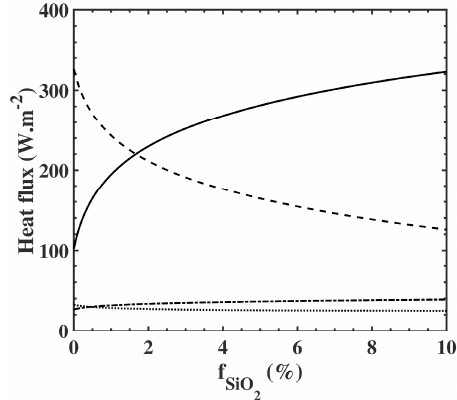
Figure 4. Representation of the radiated flux from the membrane ( m ), ( Q rad,m , black solid line), the transmitted flux from the ambient air ( a ) ( τ .Q rad,a , dashed lines), the reflected flux on the membrane toward the skin ( s ) ( ρ .Q rad,s , dotted lines), and the conducted flux through the microclimate ( mc ) (Q cond,mc , dash-dotted lines), as a function of the volume fraction of SiO 2 submicron particles. τ and p are the average transmission and reflection coefficients, defined in Supplementary Information.